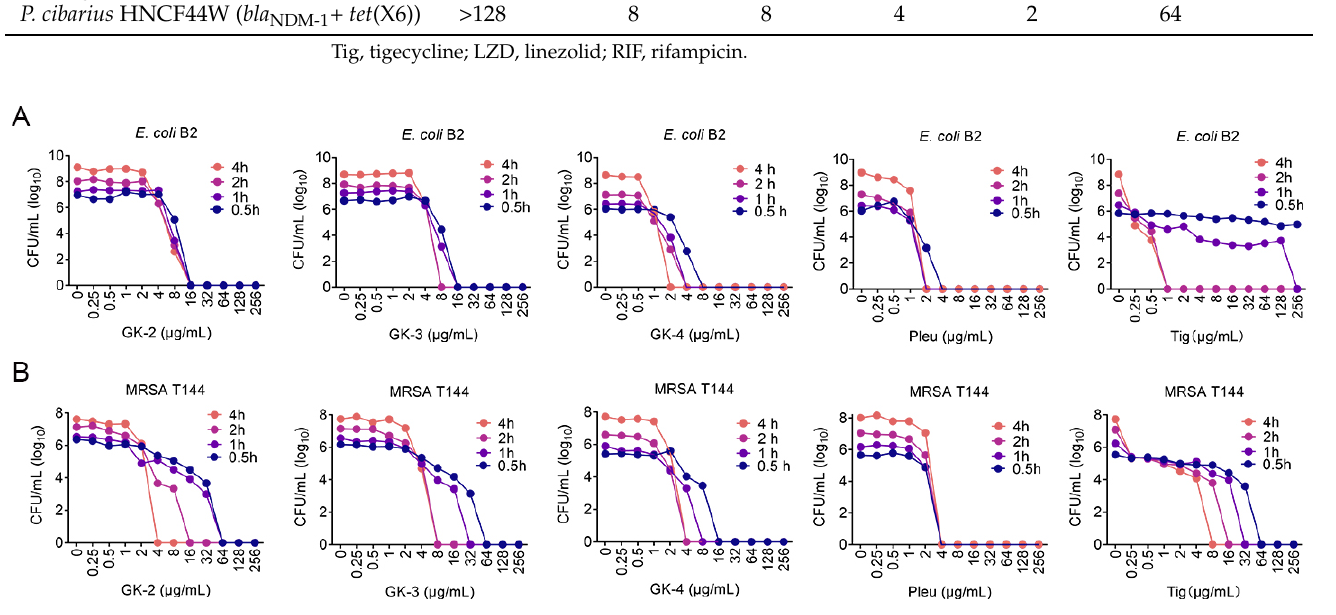
Figure 2. The inhibition curves of Pleu and its modified peptides against E. coli B2 ( A ) and MRSA T144 ( B ). The mixtures of varying concentrations of drugs (0 to 256 μ g/mL) and bacterial suspension were incubated at 37 °C for 0.5, 1, 2, and 4 h, respectively. Afterwards, 10–fold serially suspensions were plated on LB plates and incubated overnight, and the corresponding CFUs were counted and calculated. Tigecycline (Tig) was selected as a validated quality control. Experiments were conducted with biological replicates and data were presented as mean ± s.d. Table 2. Antibacterial activity of Pleu and its modified peptides against a panel of MDR pathogenic bacteria (MIC, μ g/mL).